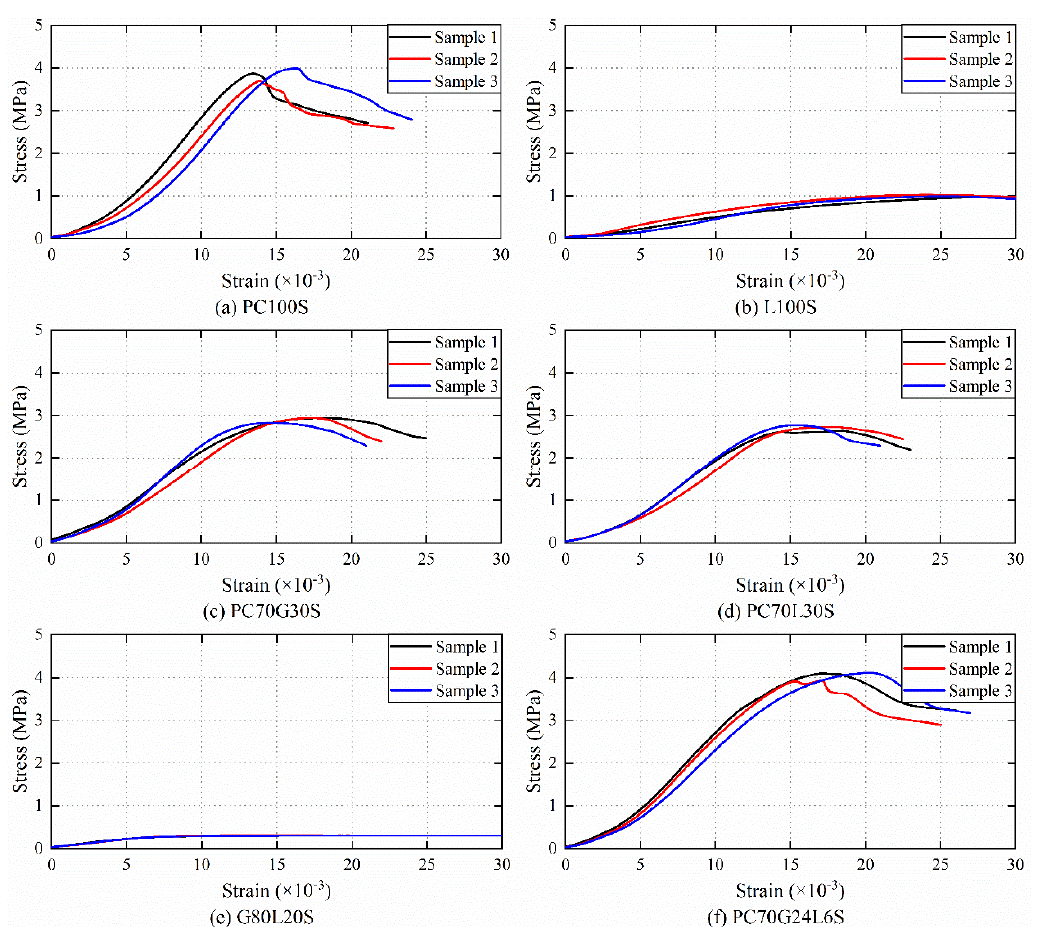
Figure 1. Stress–strain curves of the stabilized soil samples.